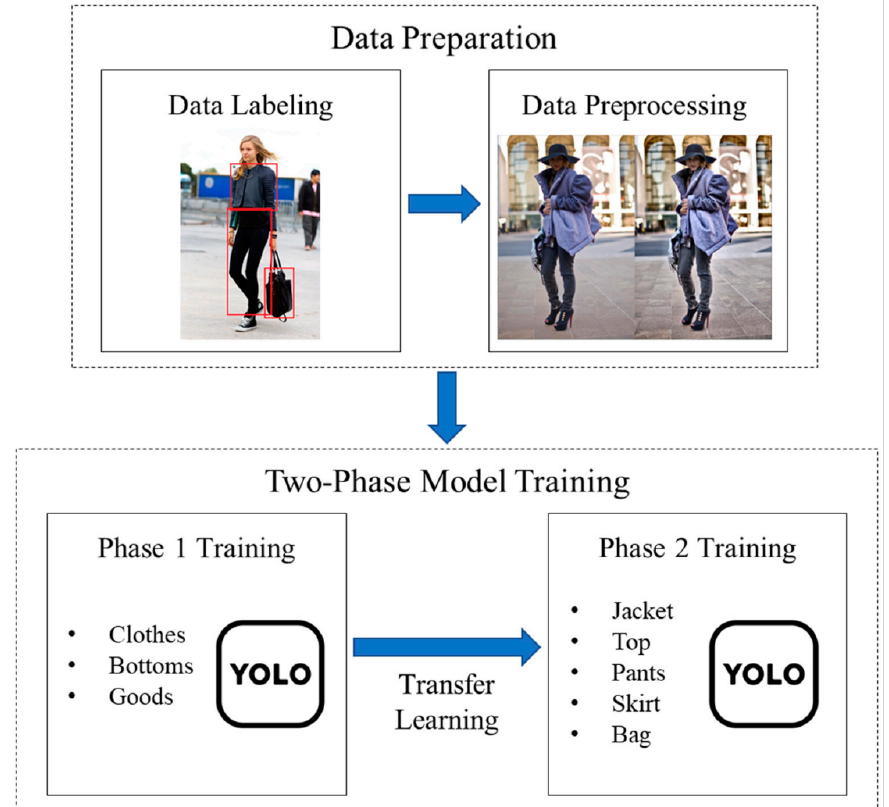
Figure 2. Training process of the